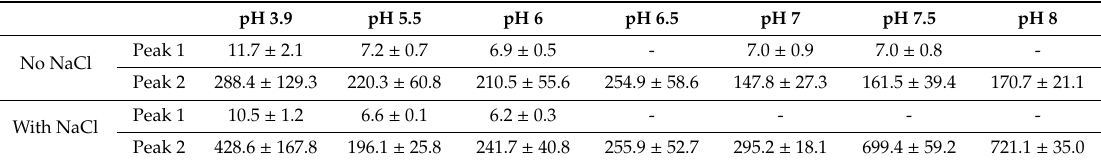
Table 1. The dependence of RL2 particle diameters (in nm) on pH and on the presence of physiological ionic